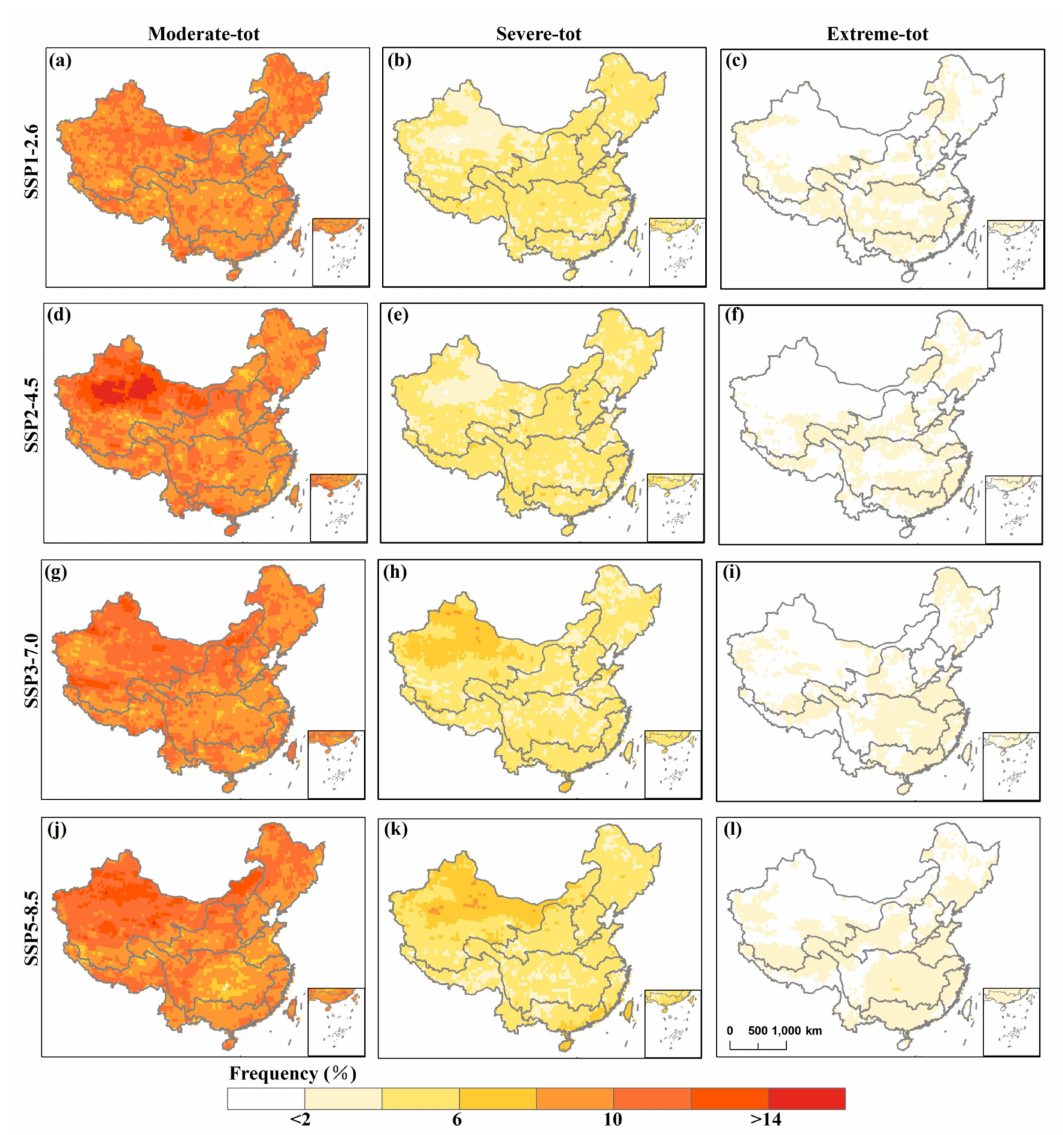
Figure 10. Comparison of the spatial distribution in the total frequency of ( a , d , g , j ) moderate drought, ( b , e , h , k ), severe drought, and ( c , f , i , l ) extreme drought across China under the ( a – c ) SSP1-2.6, ( d – f ) SSP2-4.5, ( g – i ) SSP3-7.0, and ( j – l ) SSP5-8.5 scenarios for the future period (2015–2099). The frequency of moderate drought is the ratio between the total months when − 1.5 ≤ SPEI03 < − 1 and the total length of the time series. The frequency of severe drought is the ratio between the total months when − 2 ≤ SPEI03 < − 1.5 and the total length of the time series. The frequency of extreme drought is the ratio between the total months when SPEI03 < − 2 and the total length of the time